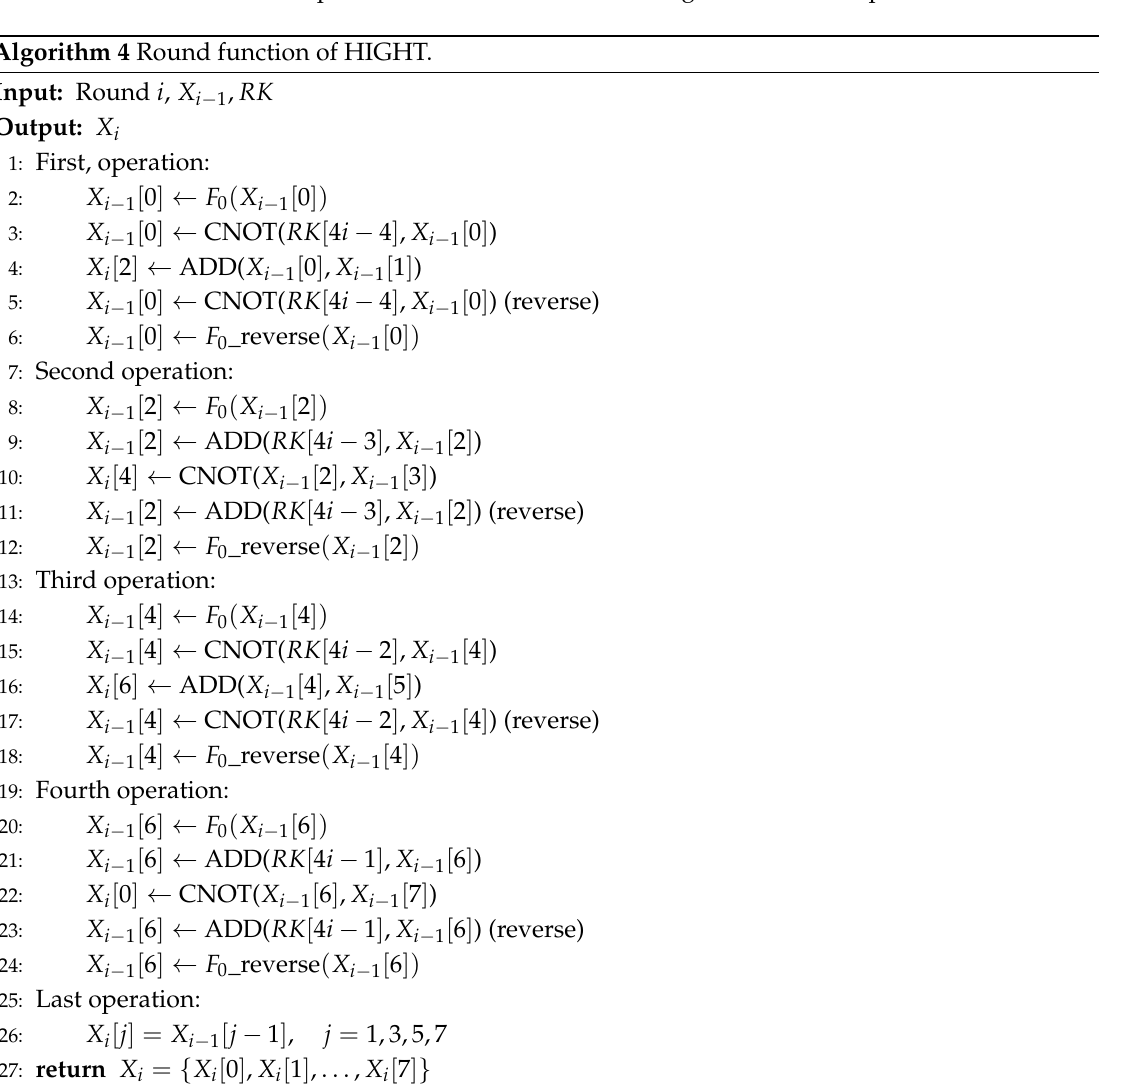
Algorithm 4 Round function of